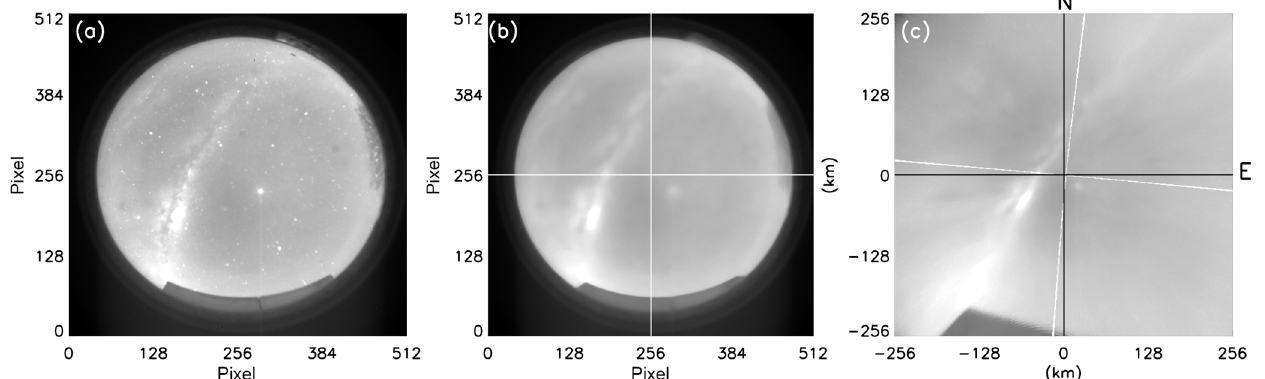
Figure 2. Sequence of images showing the pre-processing method used in the AGWs analysis. (a) Raw image of NIR-OH observed on the night of 29 October 2005 over Cariri. (b) The image after the stars have been removed. (c) The linearized and rotated image ready for the FFT analysis.